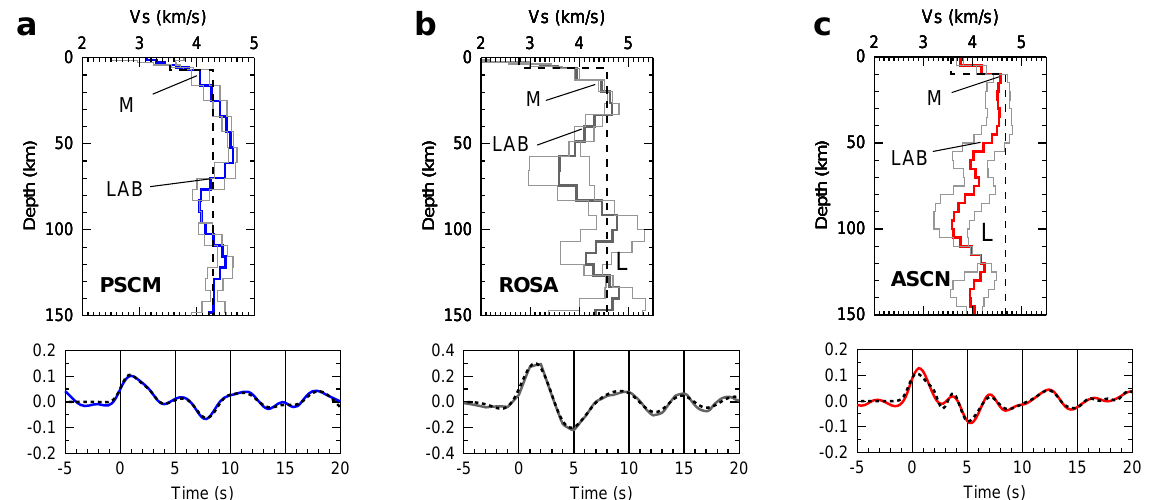
Figure 4. Models obtained by inversion of stacked traces in the bottom panel (colored as in Fig. 1) of each subplot. Synthetic traces (black dashed lines) computed from these models fit the observed traces well for the stations PSCM, ROSA and ASCN. The two gray lines that bound the thick colored lines model in the upper panel of each subplot are the ± 2SE in the velocity models derived from inversion. The dashed black line shows the 1-D starting velocity model used to invert the data.